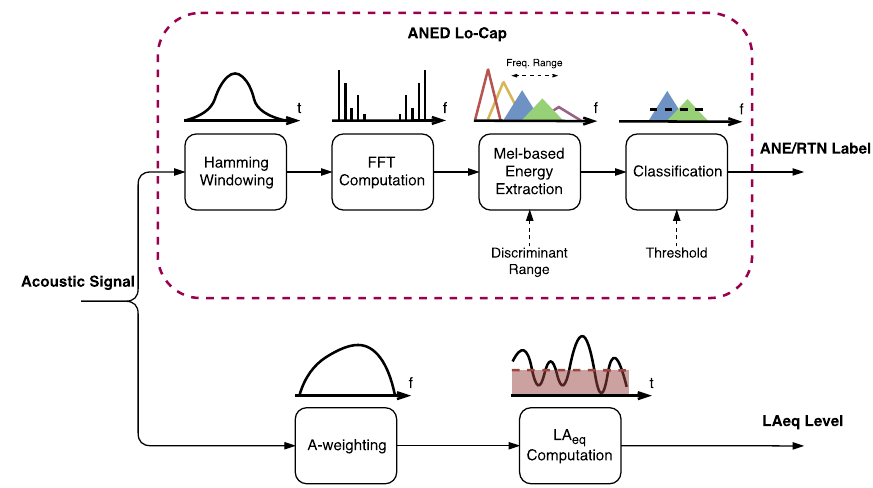
Figure 2. Block diagram of the acoustic signal processing within the Lo-Cap acoustic sensor. The upper part details the block diagram of the ANED Lo-Cap, with a binary label as an output, and the lower branch details the evaluation of the L Aeq of the measured acoustic